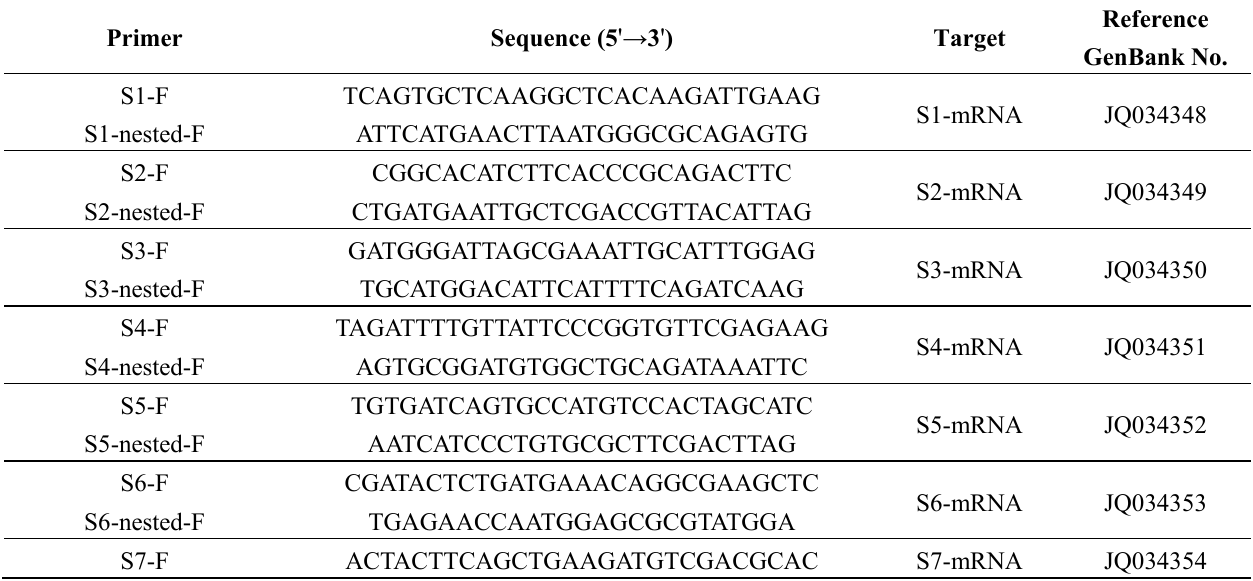
Table 1. PCR primers used in the